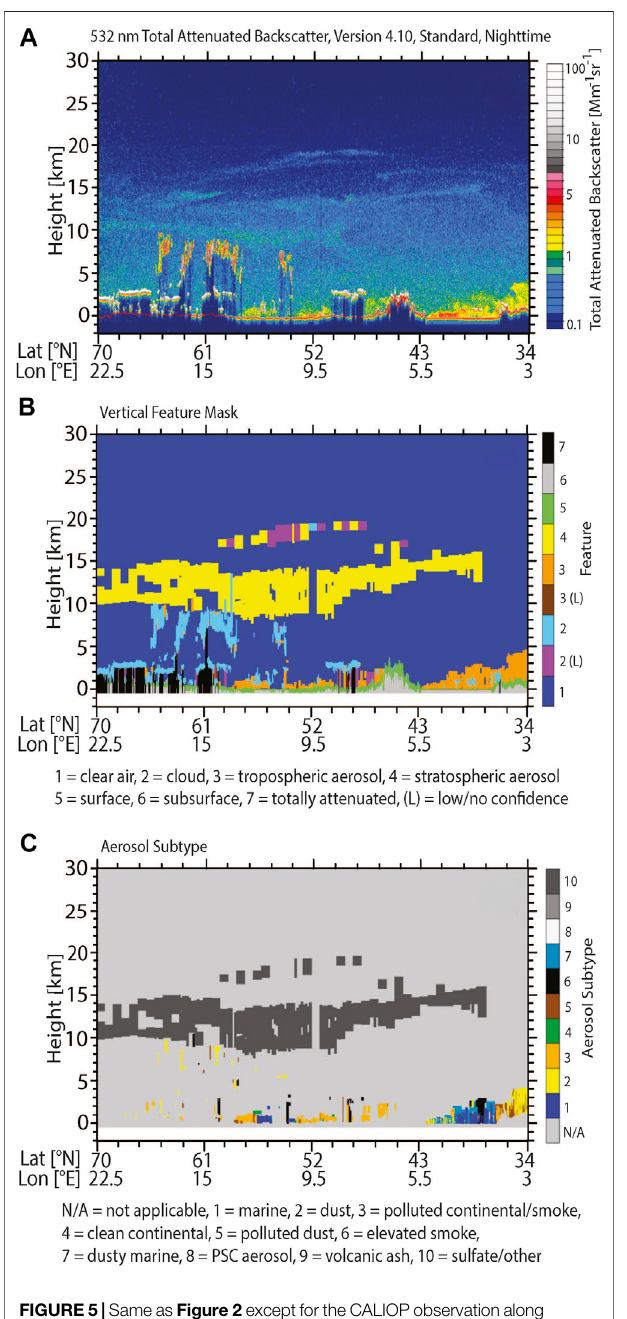
FIGURE5| Same as Figure 2 except forthe CALIOPobservation along the fl ight track crossing Sweden, Germany, and eastern France, about 150 kmwestofLeipzigonAugust14,2019,1:50 – 2:02UTC.Accordingtothe CALIPSO aerosol typing a sulfate aerosol layer is present in the lower stratosphere between about 10 and 15 km height (aerosol subtype number 10 in c).